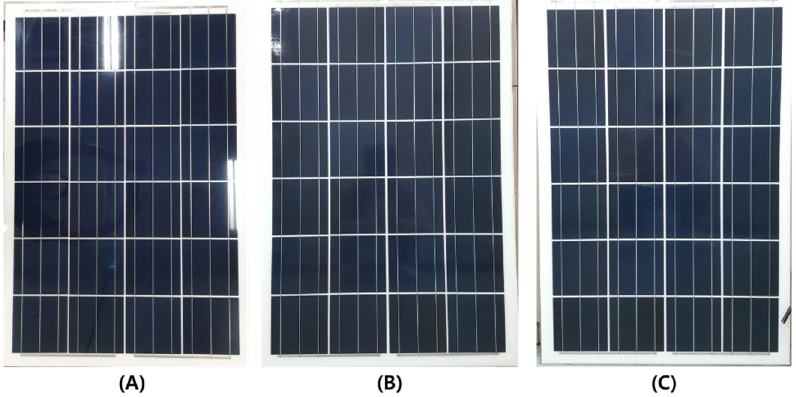
Figure 5. Actually manufactured 24-cell PV module ( A ) Ultra-barrier film, ( B ) ETFE, ( C ) ECTFE.